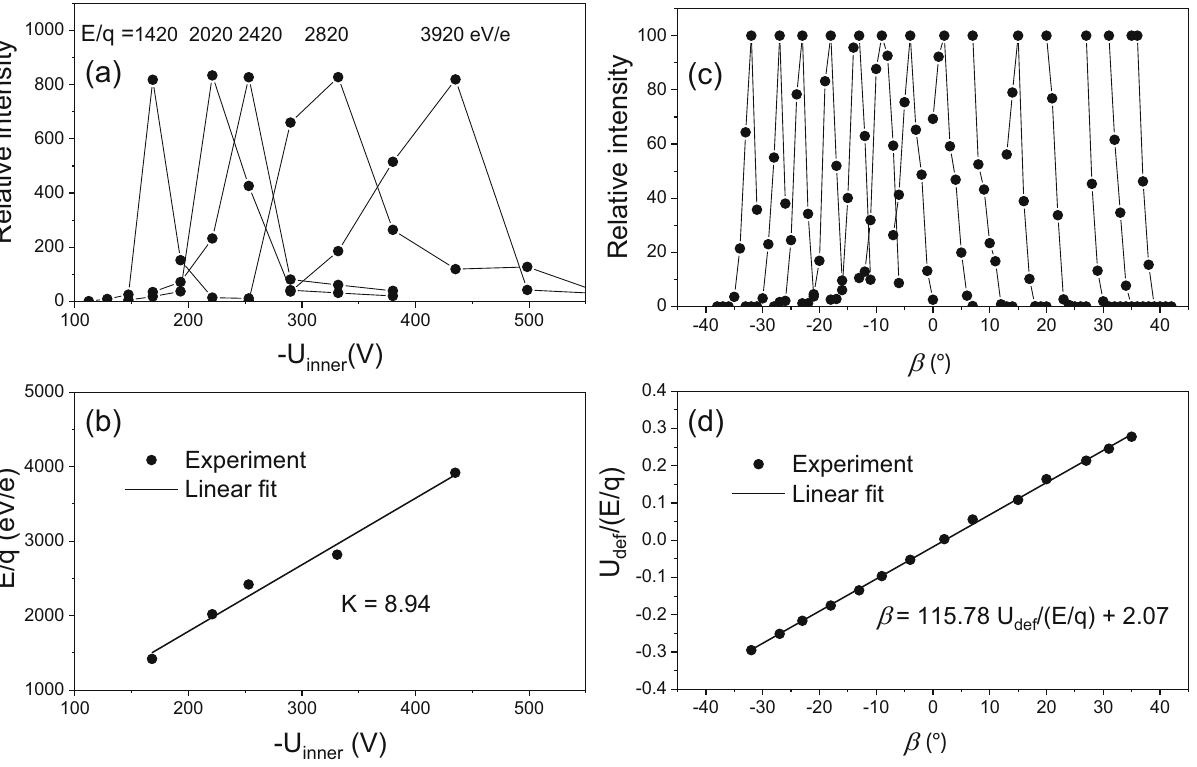
Figure 6: Calibration experimental results: ( a ) energy response spectrum, ( b ) analyzer constant K , ( c ) elevation angle response spectrum, and ( d ) the linear relationship between the elevation angle β and U def / ( E / q )